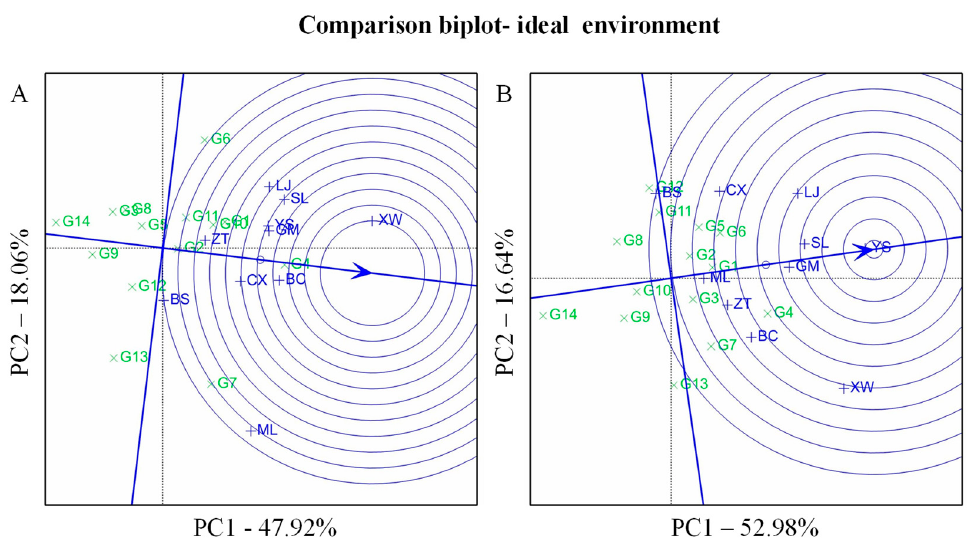
Figure 6. Visualization of ‘ideal environment’ using GGE biplot. Concentric circles show the posi-